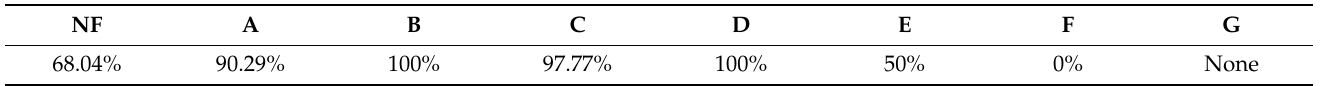
Table 6. Results per class of the best-performing model on the real-world